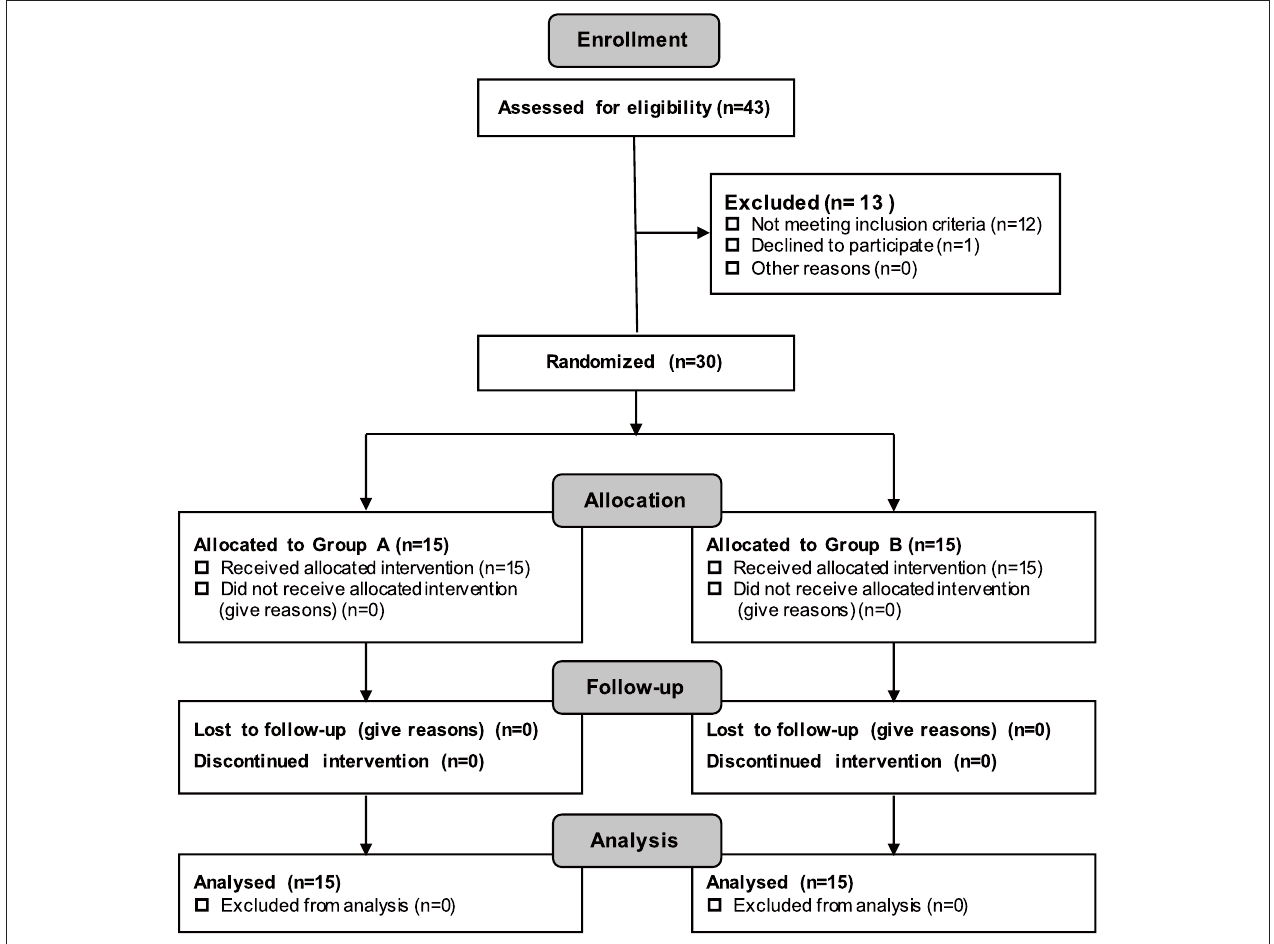
FIGURE 2 | CONSORT Diagram Demonstrating the Recruitment Process and the Recruitment